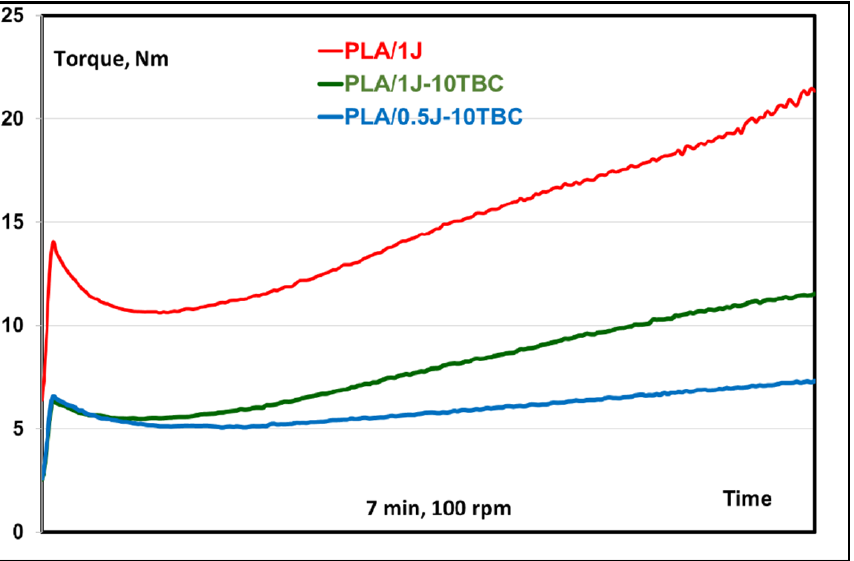
Figure 11. Comparative evolution of torque during mixing of unfilled PLA blends (without/with plasticizer) in presence of Joncryl (CE).